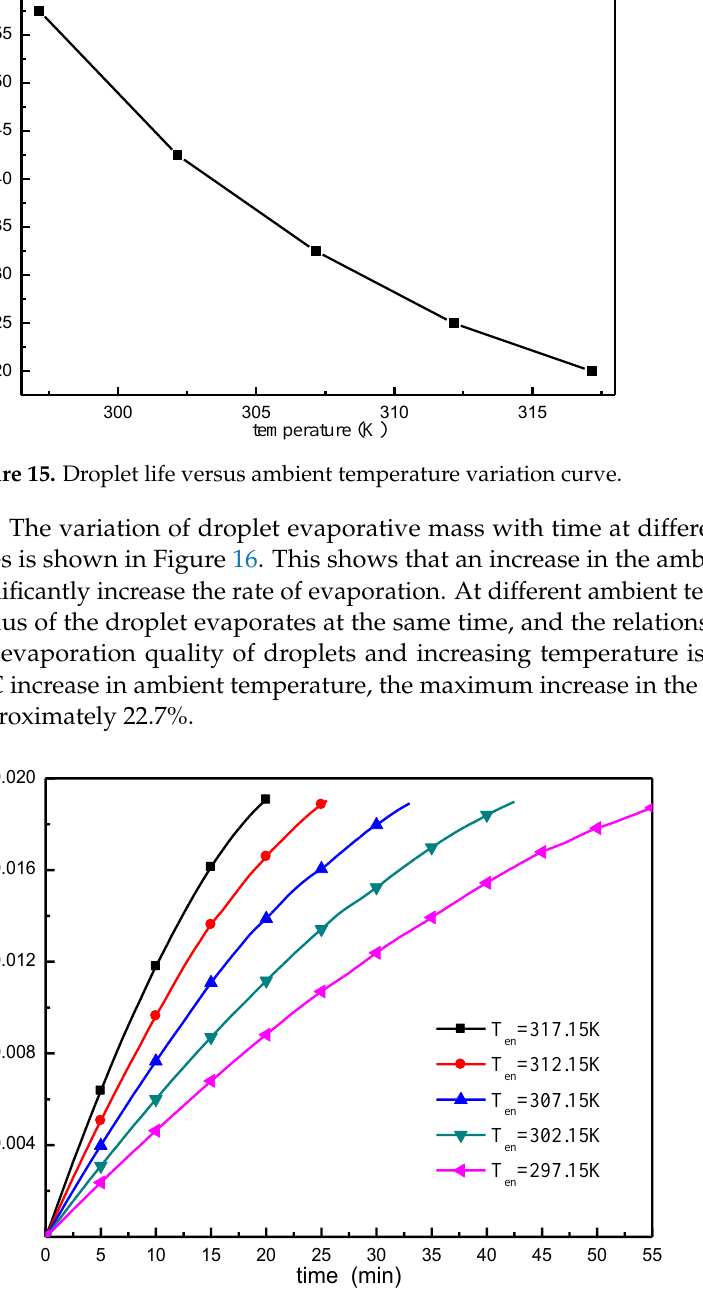
Figure 16. Variation in droplet evaporation mass at different ambient temperatures.